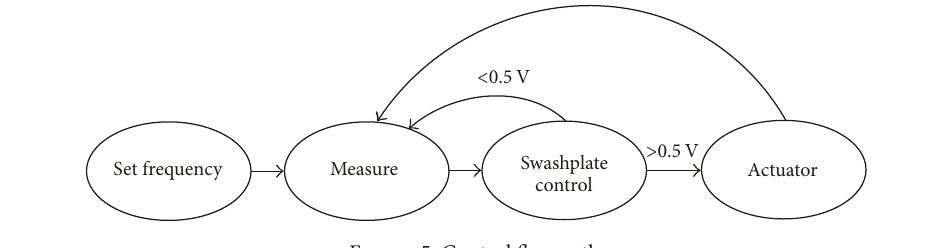
Figure 5: Control flow path.